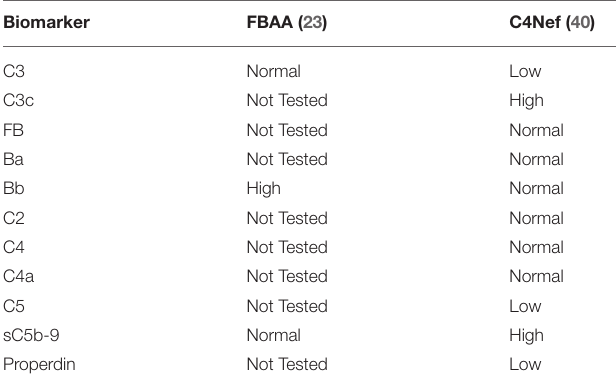
TABLE 2 | Biomarker profiles associated with Factor B autoantibodies and C4 nephritic factors.